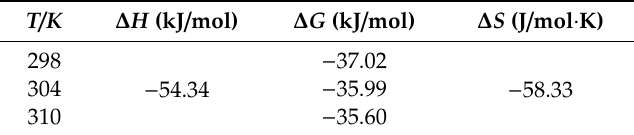
Table 4. The thermodynamic parameters of the Pv–GA